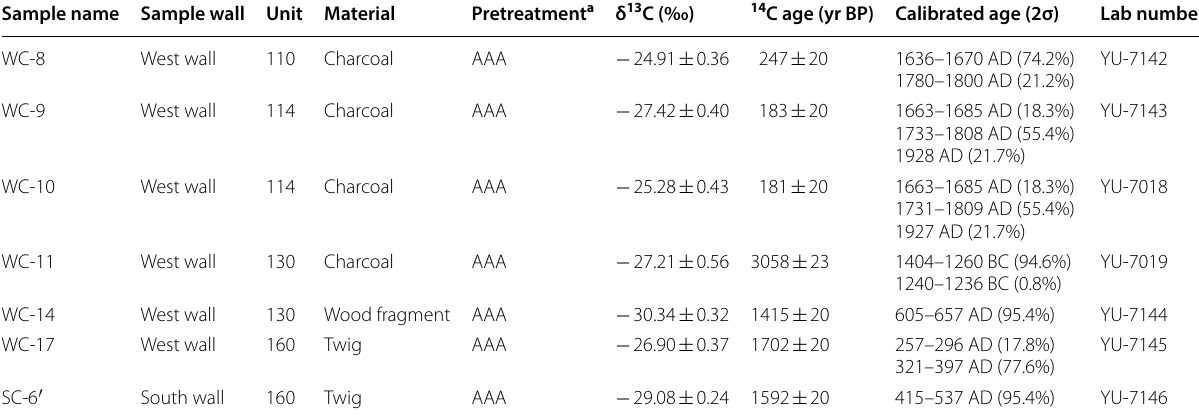
a AAA indicates that NaOH concentration reached 1.0 mol/L in acid–alkali-acid pretreatment